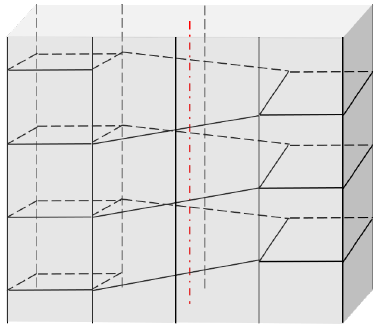
Figure 25: A lattice with a 2 × 1 smooth screw dislocation. We see that the dislocation line consists of a row of two adjacent plaquettes, and it is exactly the 2 × 1 smooth hole with a screw